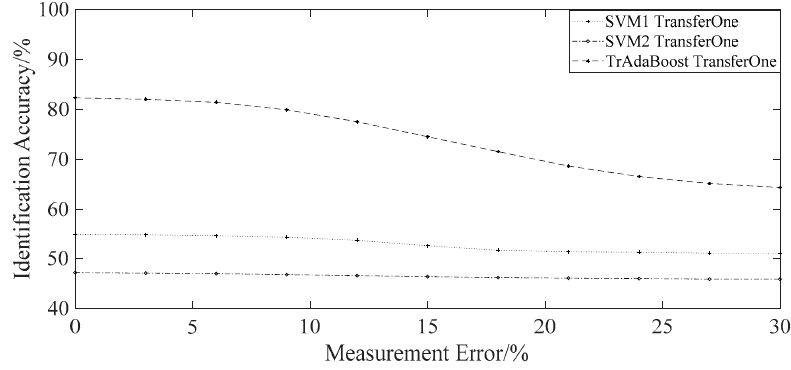
Figure 3. Contrast experiment results in the case where the target domain contains only a small number of labeled samples.